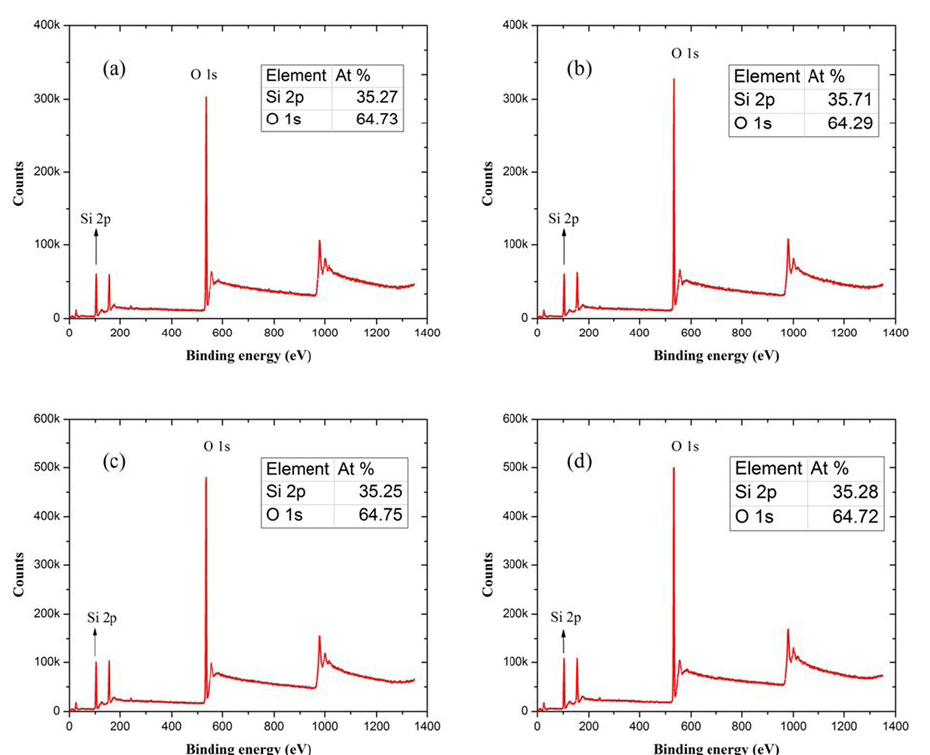
/Ar flow ratios of (a) 1:7, (b) 1:3, (c)1:1, and (d) 3:1 with a 2